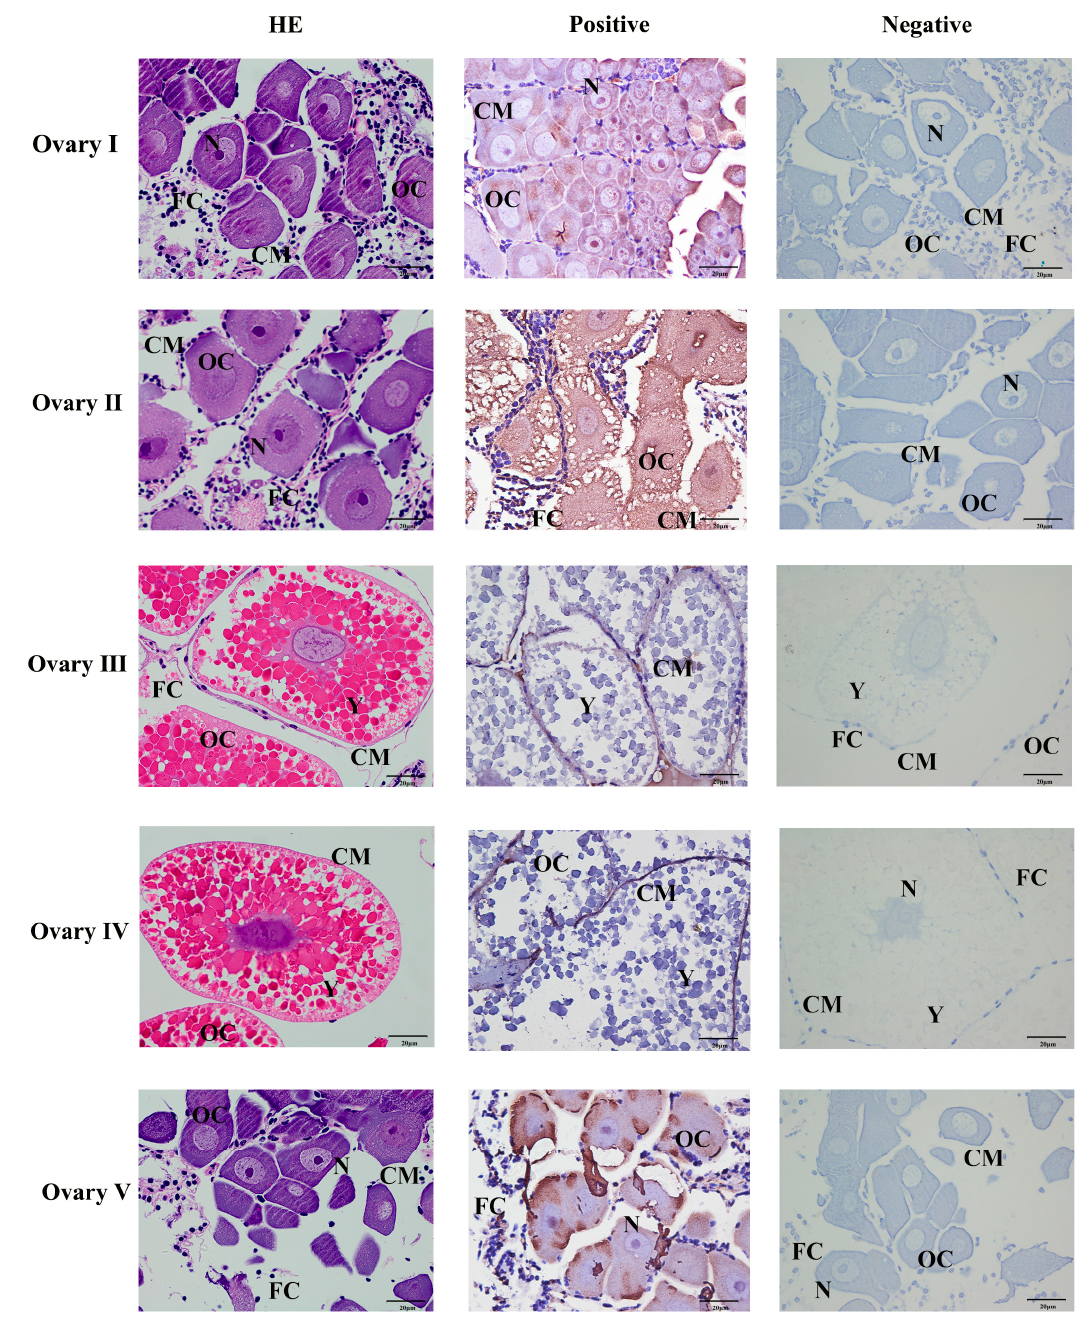
Figure 5. Localization of the expression of Mn-CH7D mRNA in Macrobrachium nipponense ovaries using in situ hybridization. OC: oocyte; N: nucleus; CM: cytoplasmic membrane; Y: yolk granule; FC: follicle cell; Scale bars: High magnification 400 ×.